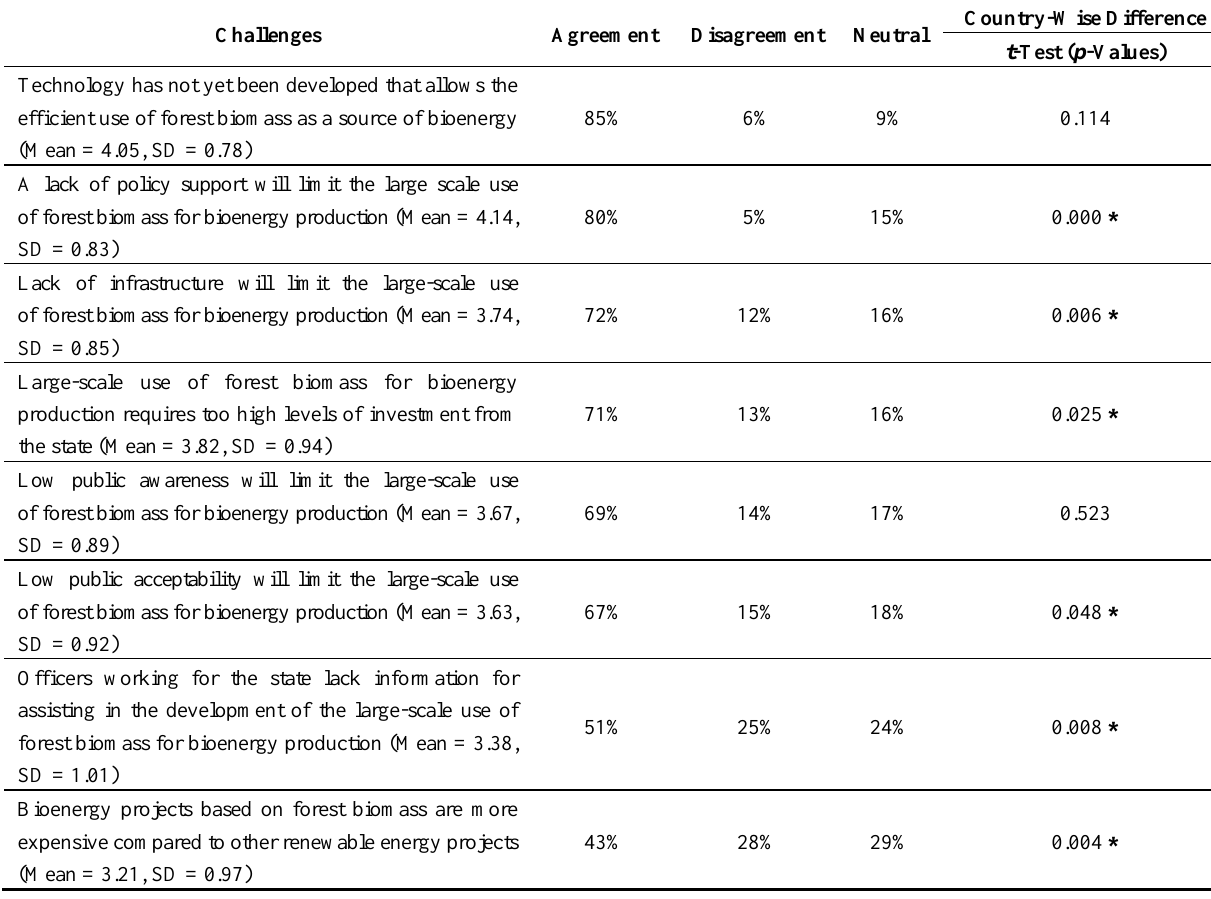
Table 2. State forestry professionals’ perceptions of the potential challenges against developing forest-based bioenergy projects in China and